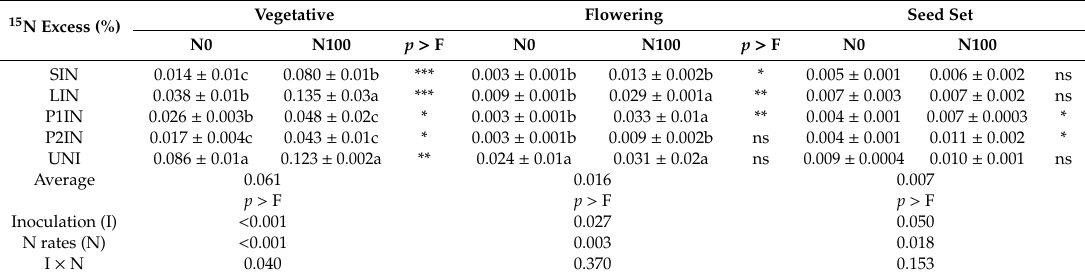
Table 5. Average ( ± standard error) atom% 15 N excess of leaf sulla (% 15